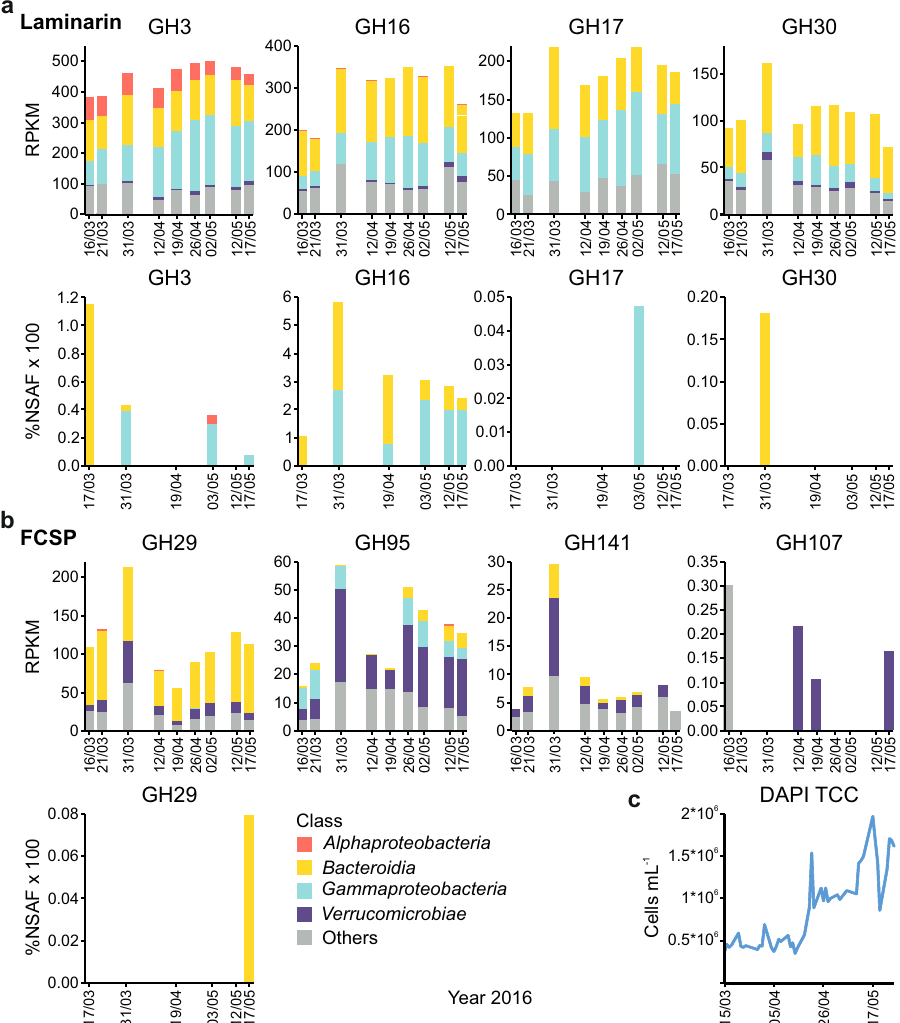
Fig. 3 Content and expression of particular CAZymes by marine bacteria during the algal bloom. Plots show abundances of genes coding for carbohydrate-active enzymes (CAZymes) with relevance for degradation of two selected glycan substrates in the genomes of marine bacteria (at the top of each panel) and their expression during the bloom (at the bottom of each panel). Selected substrates are: β -1,3-glucan, laminarin ( a ) and fucose- containing sulphated polysaccharide, FCSP ( b ). Complete CAZymes metagenomic analysis and complete proteomic data are shown in Supplementary Fig. 7. Reads per kilobase per million (RPKM). Proteome data were analysed in a semiquantitative manner based on normalised spectral abundance factors (%NSAF). Both analyses include class-level taxonomic classi fi cations, see Methods section. Glycoside hydrolase family (GH). c DAPI-based total microbial cell counts (TCC) during the diatom bloom of